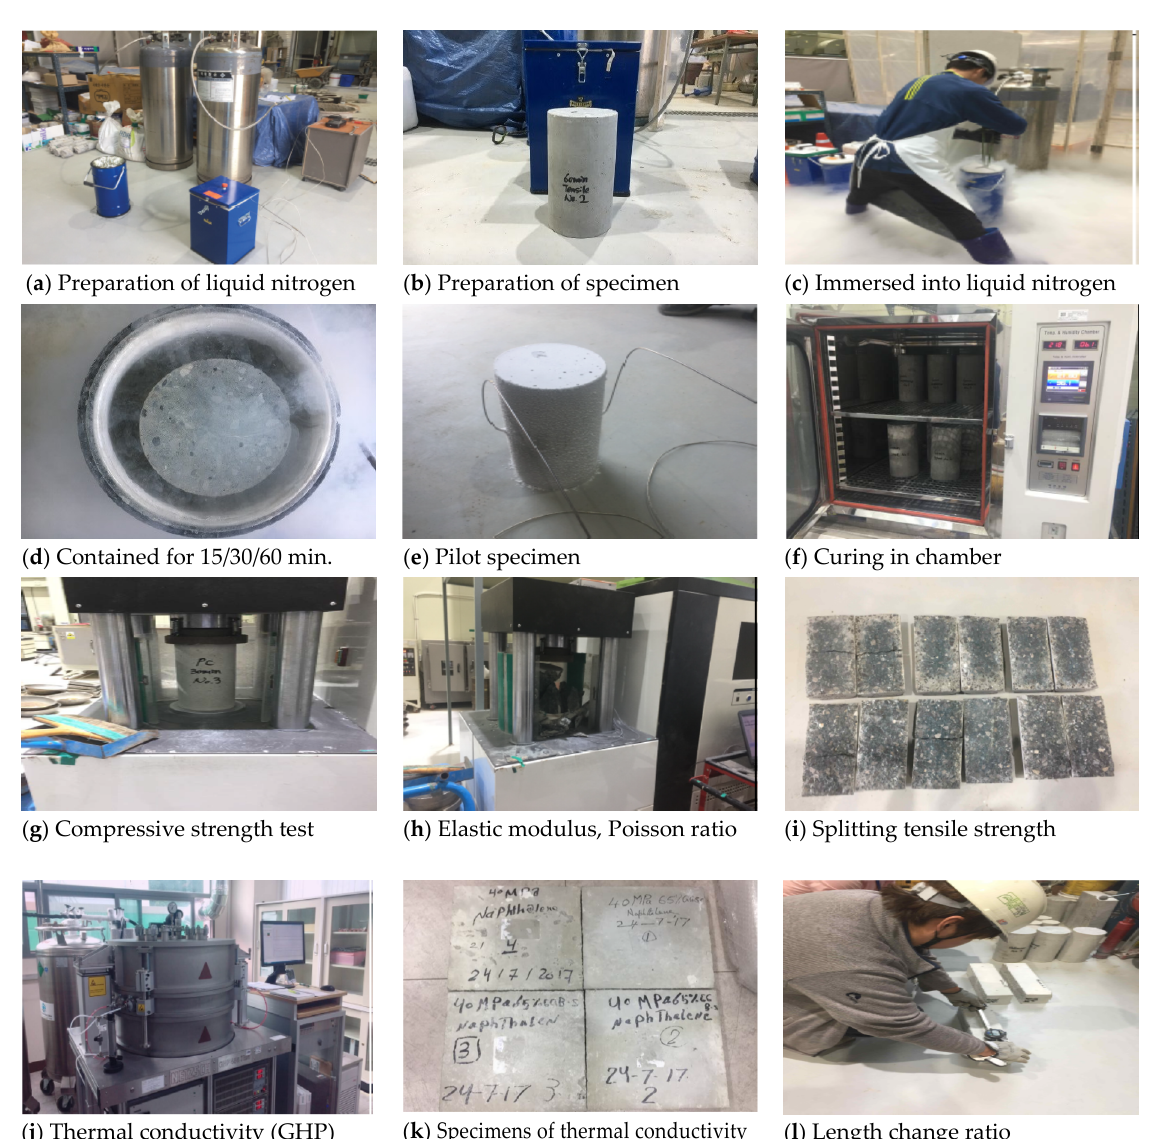
Figure 3. Test A method under cryogenic condition .